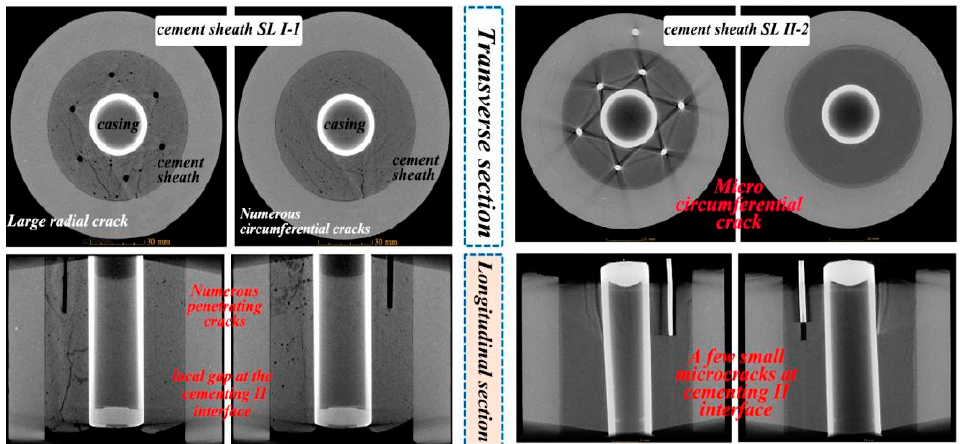
Figure 6. Transverse/longitudinal section of the CT scan.